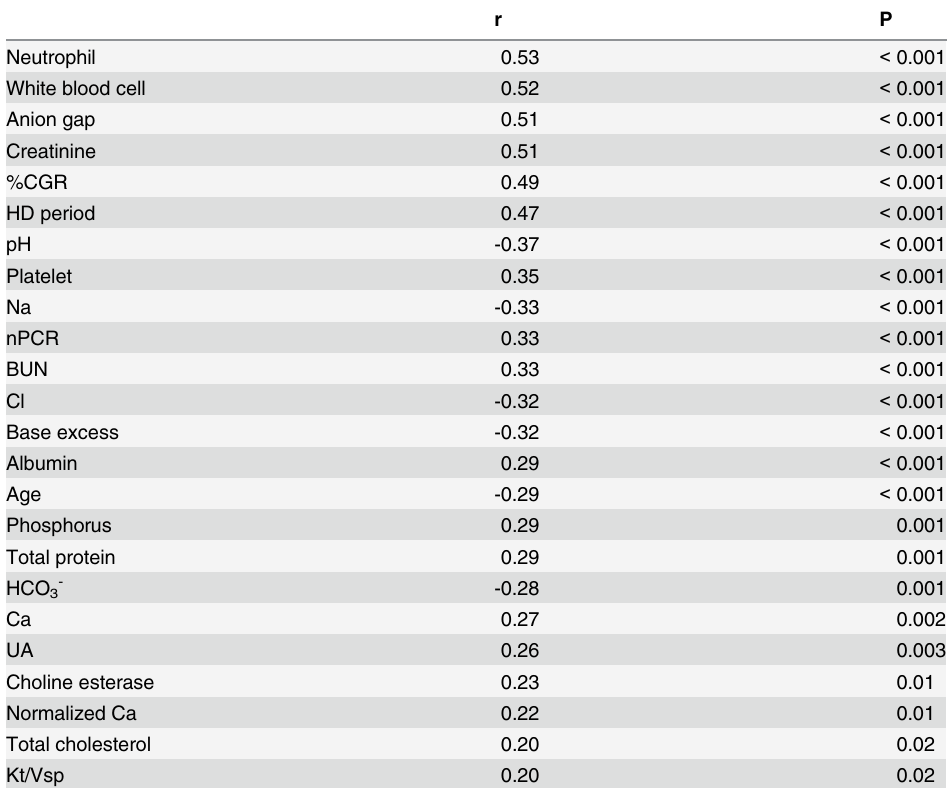
Among clinical parameters shown in Table 1, parameters which had signi fi cant correlations to serum NGAL levels are shown (P < 0.05, respectively). N = 139. Correlations of the rest of parameters are shown in S3